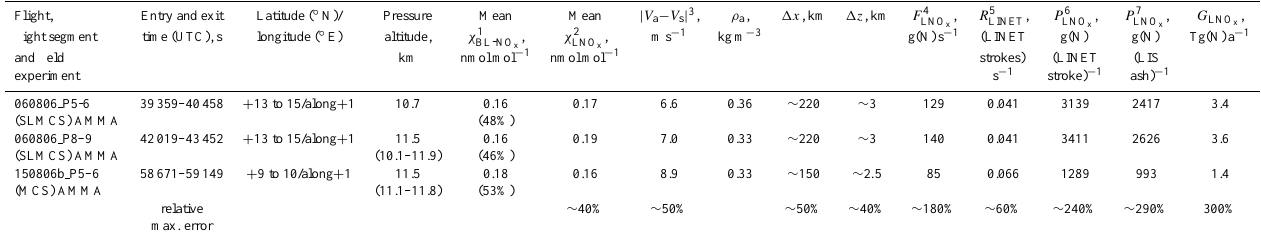
Table 3. Estimates of horizontal LNO x mass flux F LNO flash P LNO , and global LNO x production rate per year G LNO x